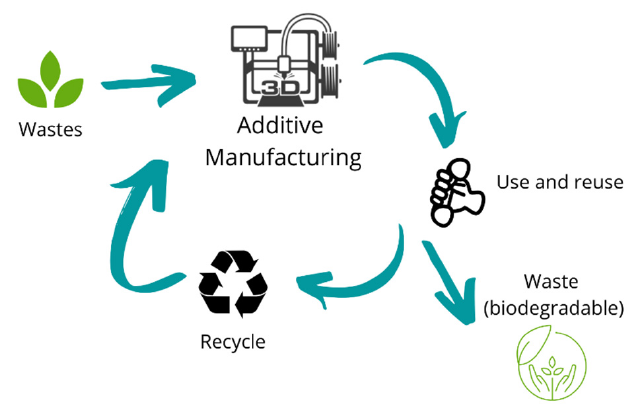
Figure 8. Additive manufacturing in a circular economy model.